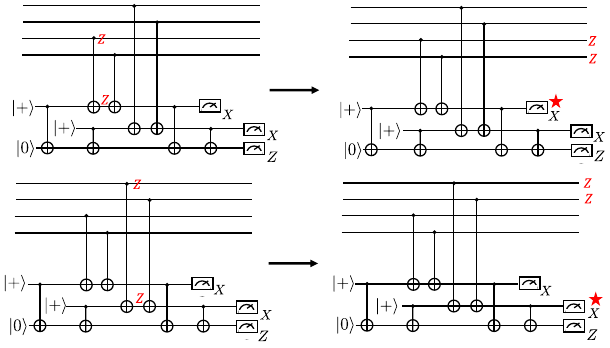
FIG. 9. Flag outcomes arising from a single fault resulting in a weight-two data qubit error during the measurement of a weight- four operator. In this example, the flag qubits are prepared in the jþi state and measured in the X basis. Starred measurements give a nontrivial outcome due to the errors. In the above examples, if the ZZ error is replaced by an IZ error, the same flag outcomes will occur resulting in a weight-one data qubit